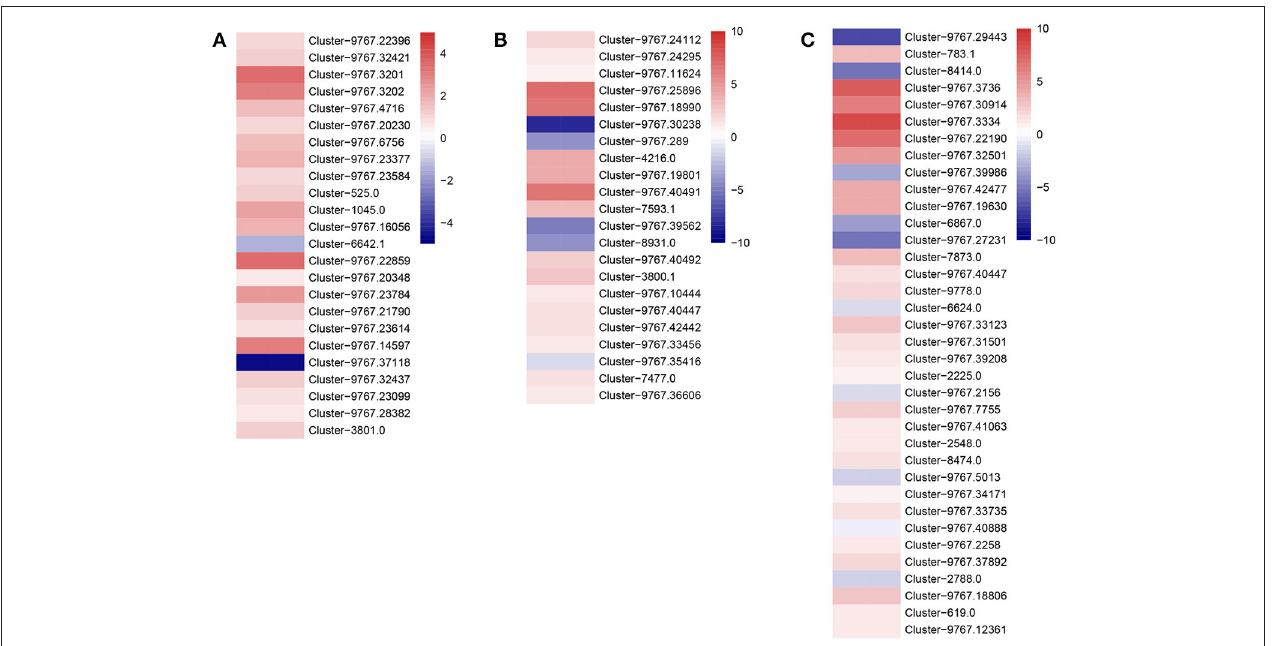
FIGURE 6 | Heatmaps of expressions for genes with energy metabolic signaling. (A) Genes with functions in fatty acid metabolism. (B) Genes with functions in sugar metabolism. (C) Genes with functions in amino acid